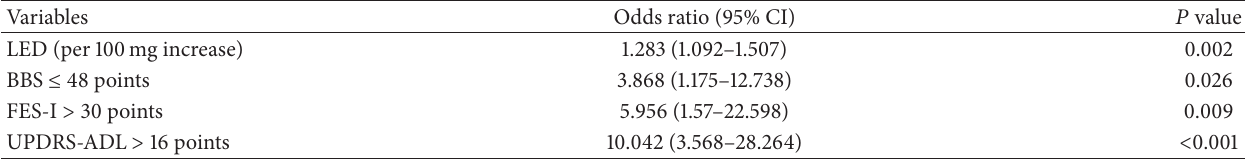
Table 2: Multivariate logistic regression analysis of the sample ( 𝑛 = 164